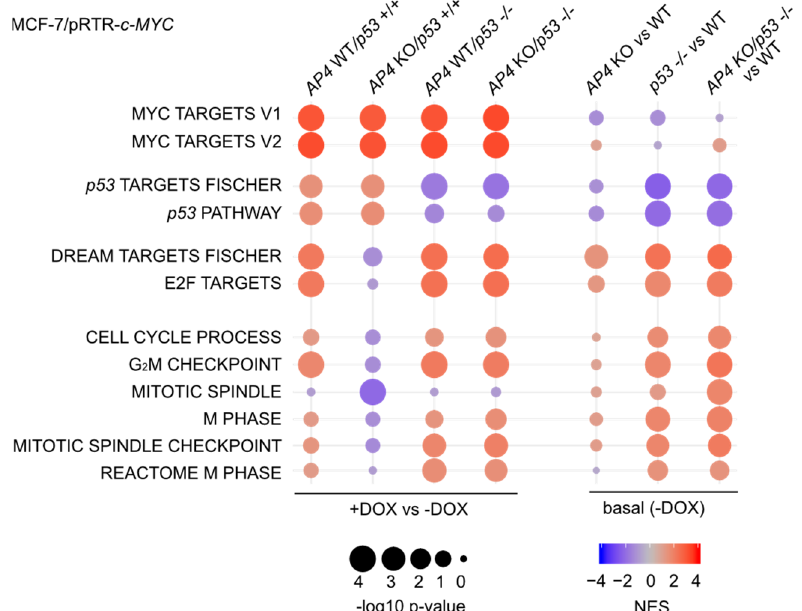
Figure 6. Loss of AP4 results in p53-dependent differences in c-MYC-induced RNA expression changes of genes involved in cell proliferation. Dot plot representation of gene set enrichment analyses (GSEA) of the indicated functional categories obtained from comparisons of DOX-treated (48 h DOX) vs. untreated samples of the indicated genotypes (left), as well as the comparison of basal (no DOX treatment) expression levels in the indicated genotypes vs. AP4/p53 wild-type cells (WT). The significance of enrichments is presented by normalized enrichment scores (NES) and Benjamini-Hochberg-adjusted p values.